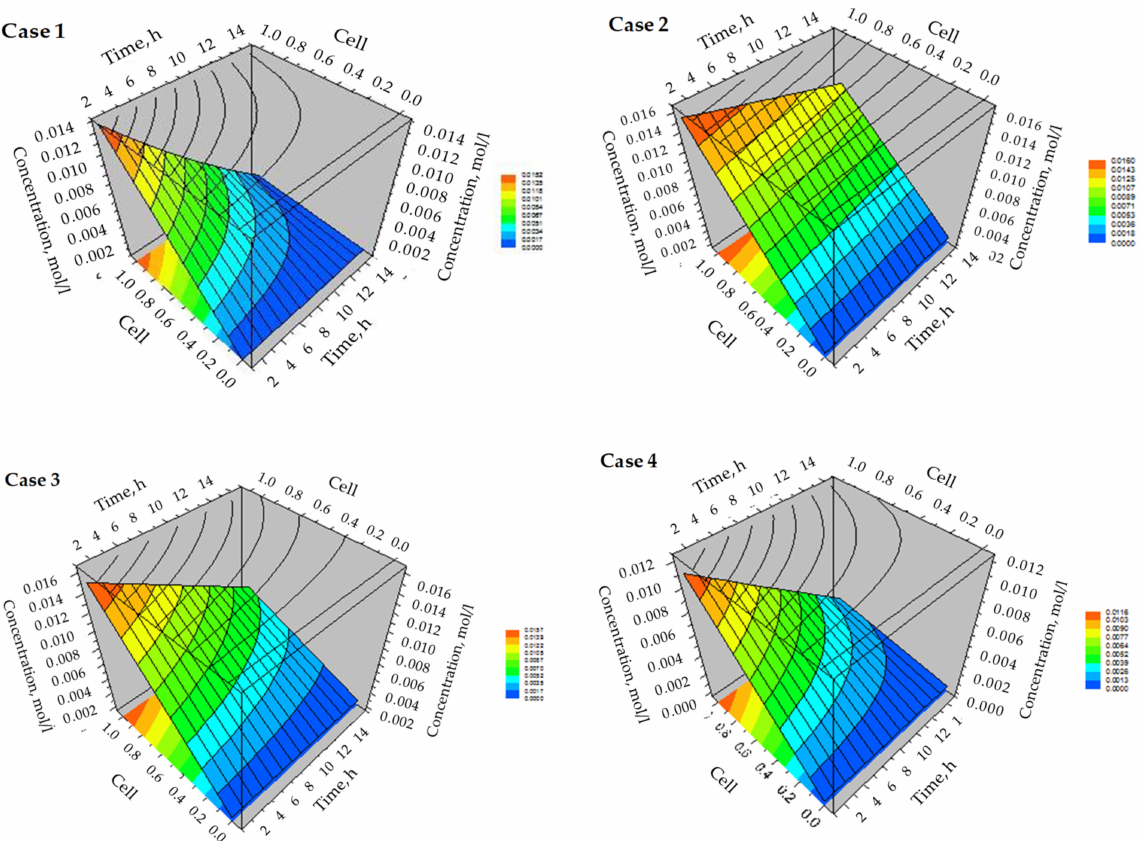
Figure 13. 3D concentration distribution of CO 2 in a discretization cell of the adsorption bed for the cases of a pilot plant capture